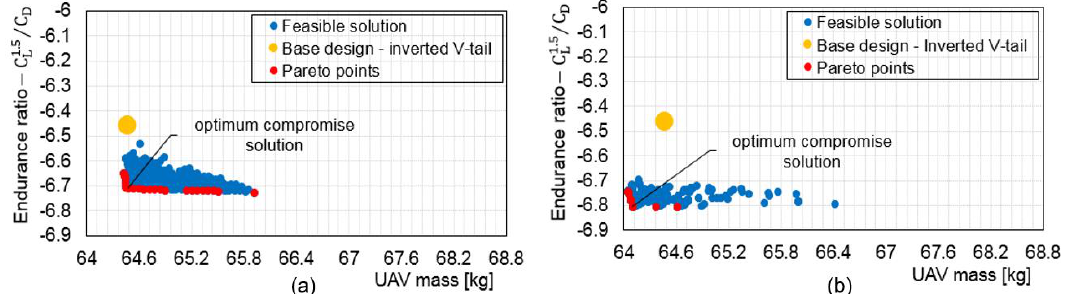
Figure 10. Optimisation results for the Aegis UAV with inverted V-tail. (a): optimisation results using wing design variables using only 2400 evaluations (average run time 38 min). (b): optimisation results using wing and tail components simultaneously using 5500 evaluations (average run time 126 min).